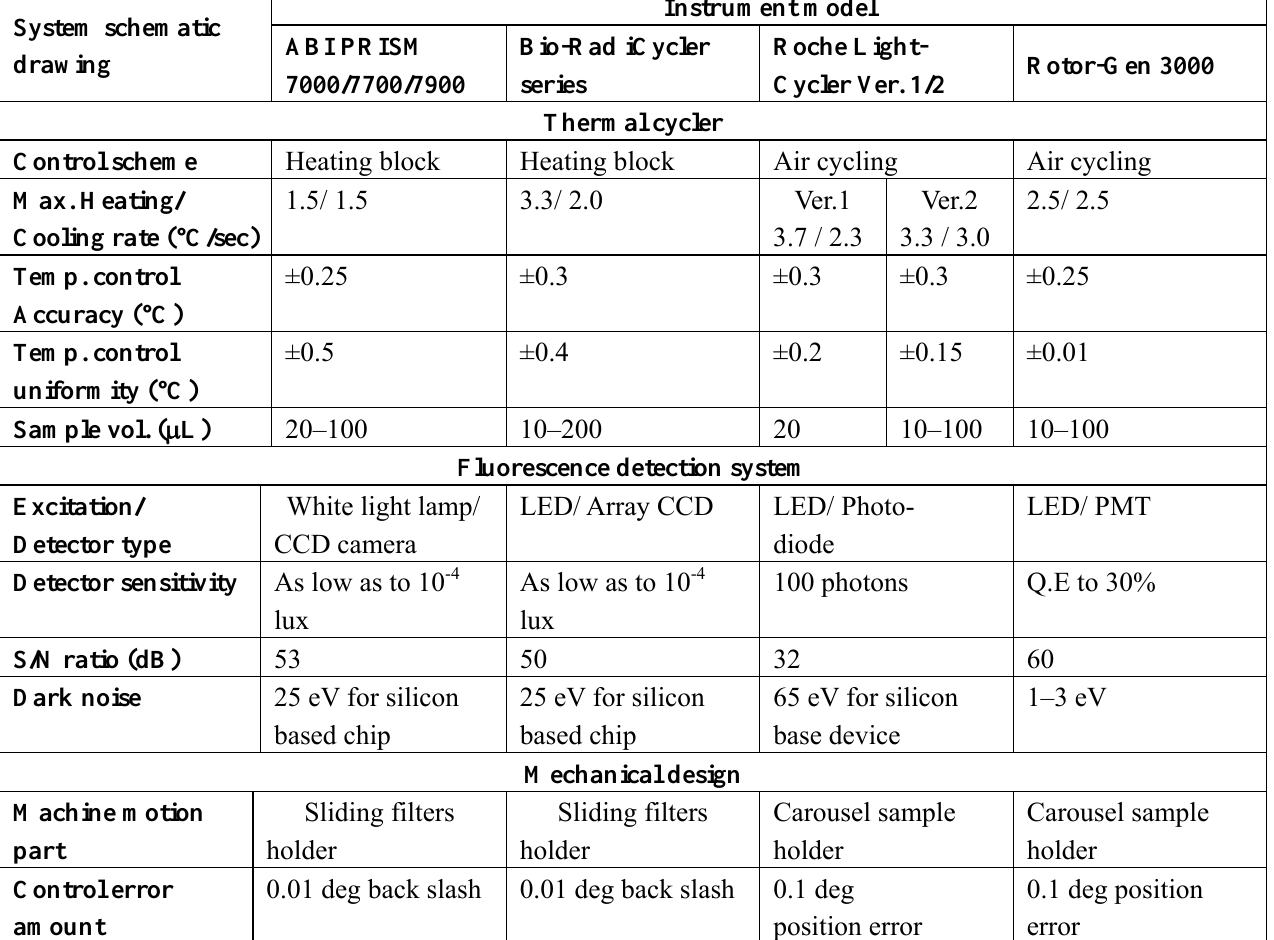
Table 1. The specifications of commercial real-time PCR machines diverse in thermal cycler, fluorescence detection system, and mechanical design. The most influential factors on the noises of DNA quantification are analyzed- and pointed out